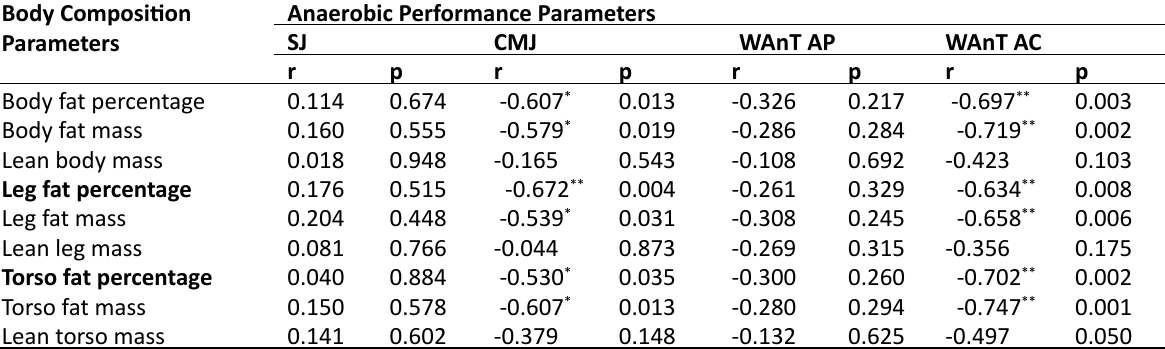
Table 3. Relationships between total/segmental body composition and anaerobic performance parameters on female handball players Body